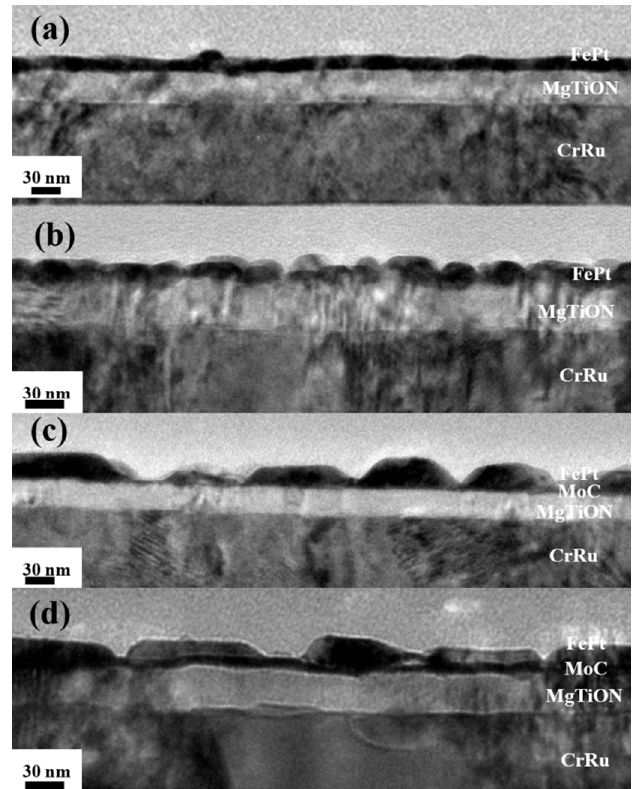
Figure 3. The cross-sectional TEM images of the FePt(BN, Ag, C)( x vol.%)/MoC( y nm)/MgTiON/CrRu/glass films, ( x , y ) = ( a ) (0, 0), ( b ) (10, 0), ( c ) (0, 3), ( d ) (10, 3).